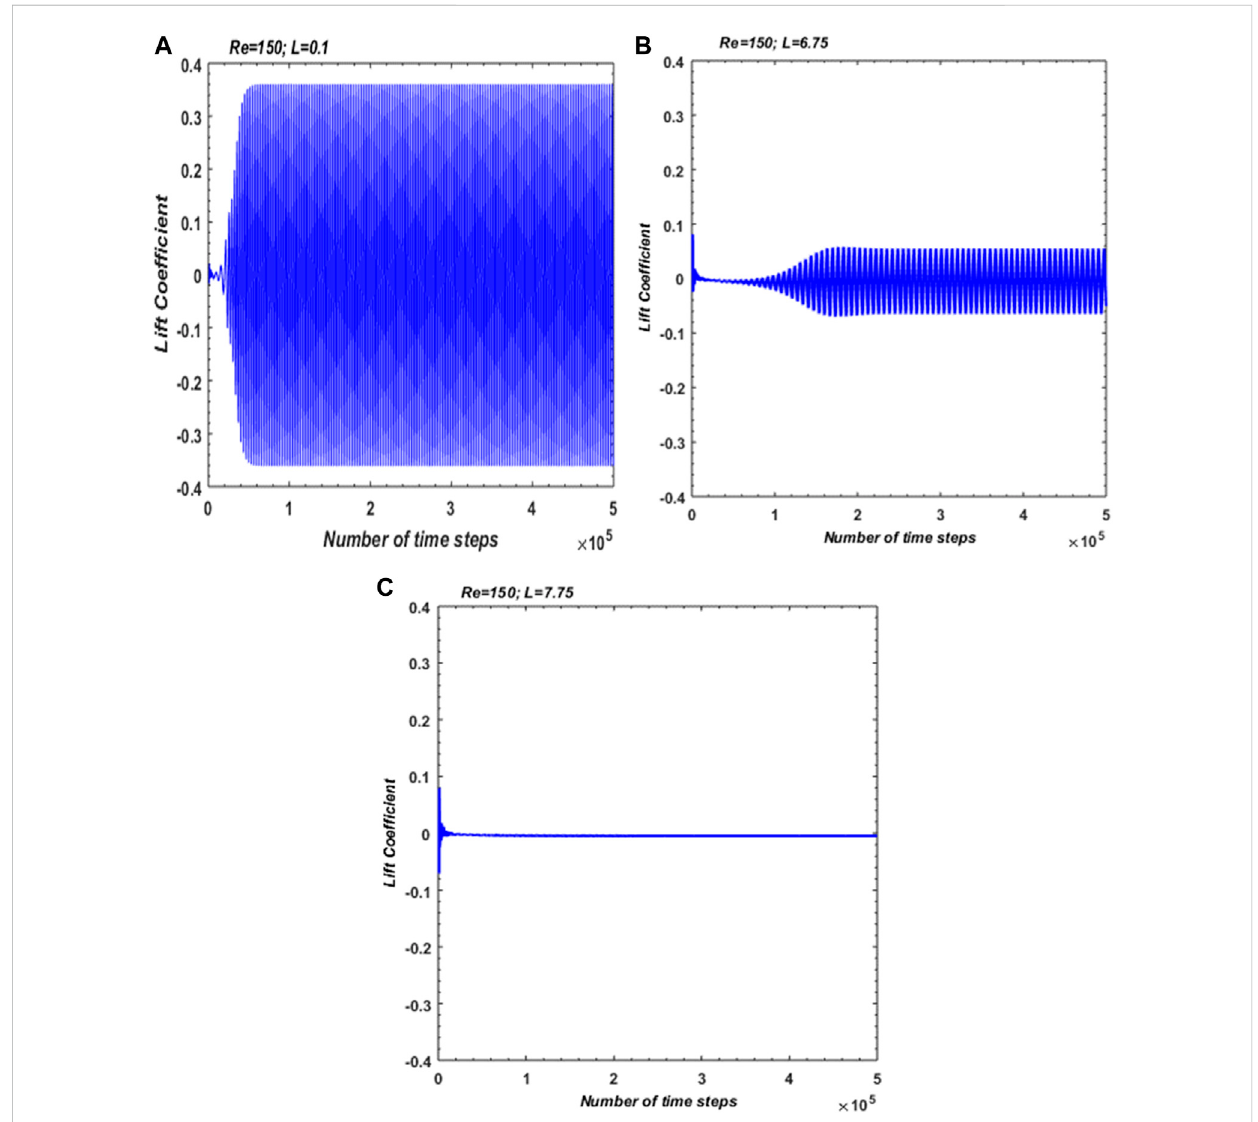
FIGURE 7 CL graphs corresponding to different fl ow modes: (A) Unsteady, (B) Tranisent, and (C) Steady fl ow mode.